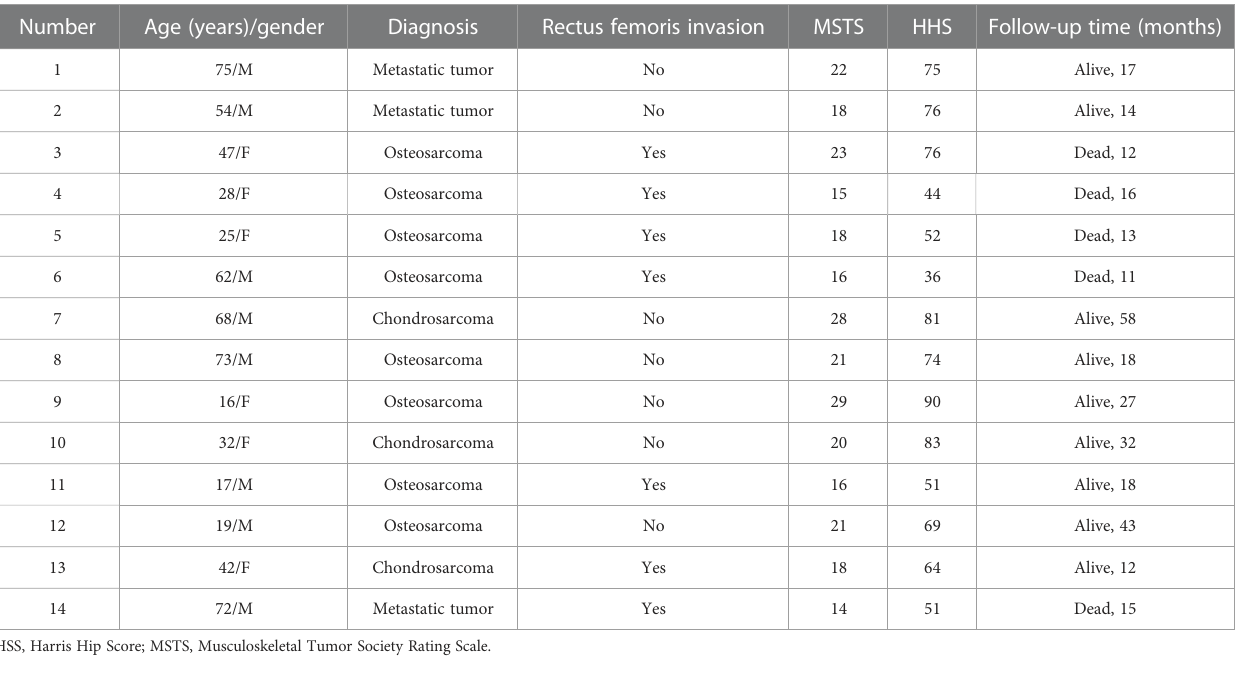
TABLE 1 Clinical characteristics of the included patients.